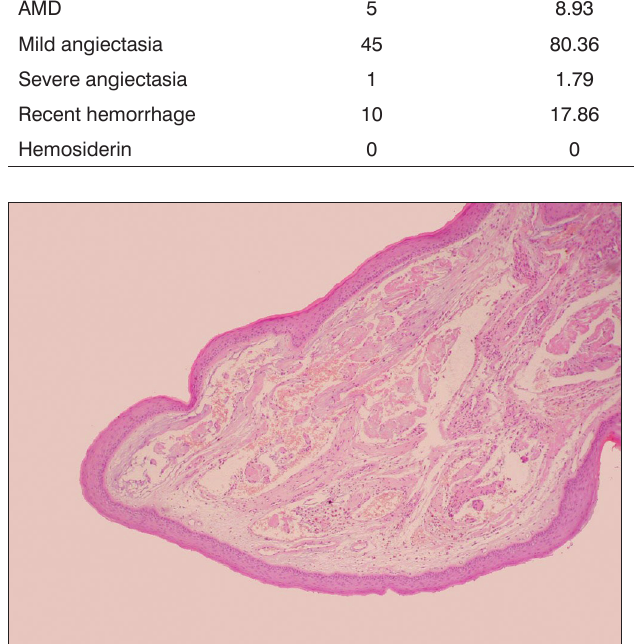
Figure 1. Histology of Vocal Cord Polyp. Overview of the vocal fold polyp histology stained with hematoxylin and eosin (HE 20x). Notice the intact epithelium and the thin basement membrane. In the lamina propria there are vascular changes, amorphous material deposits, past hemorrhage and hemosiderin.